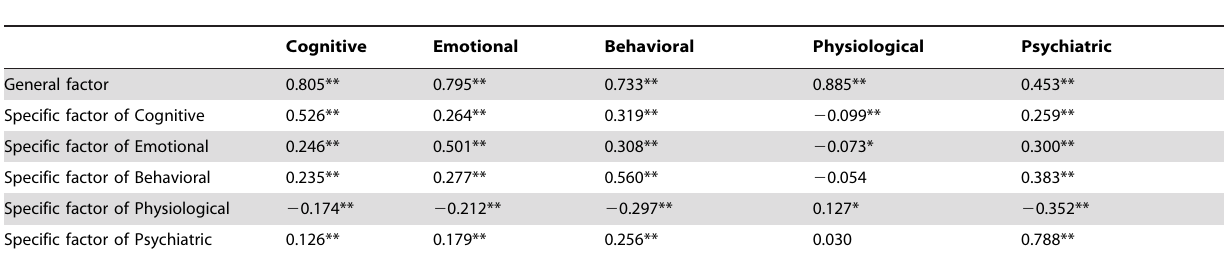
Table 4. Correlations between CTT and Bifactor Analysis Results of ASRS.